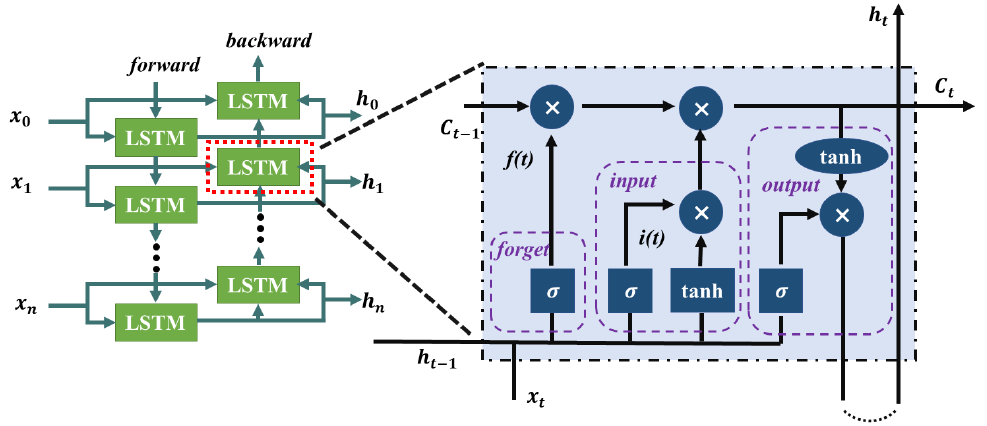
Figure 5. BiLSTM network structure